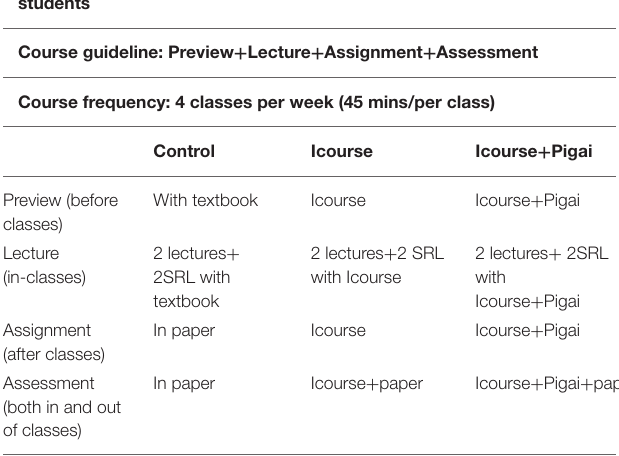
TABLE 2 | The EFL academic writing course